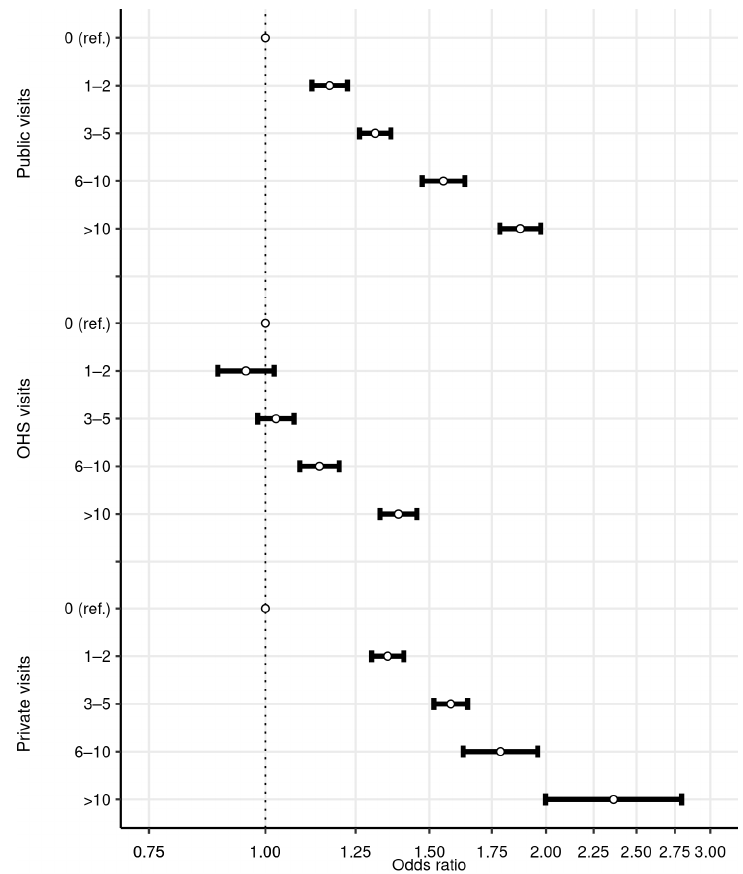
Figure 4. Logit results for dentist visits, by number of medical visits in separate sectors (odds ratios with their 95% confidence intervals). Dependent variable is a binary variable indicating whether the resident has at least one dentist visit. Covariates included in the regression but not shown in the figure are sex, age group, education, occupational class, income quintile, and the number of entitlements to special medicine reimbursement. All parameters are estimated from the same regression. The x-axis is log-scaled. The sample size is 91,060.